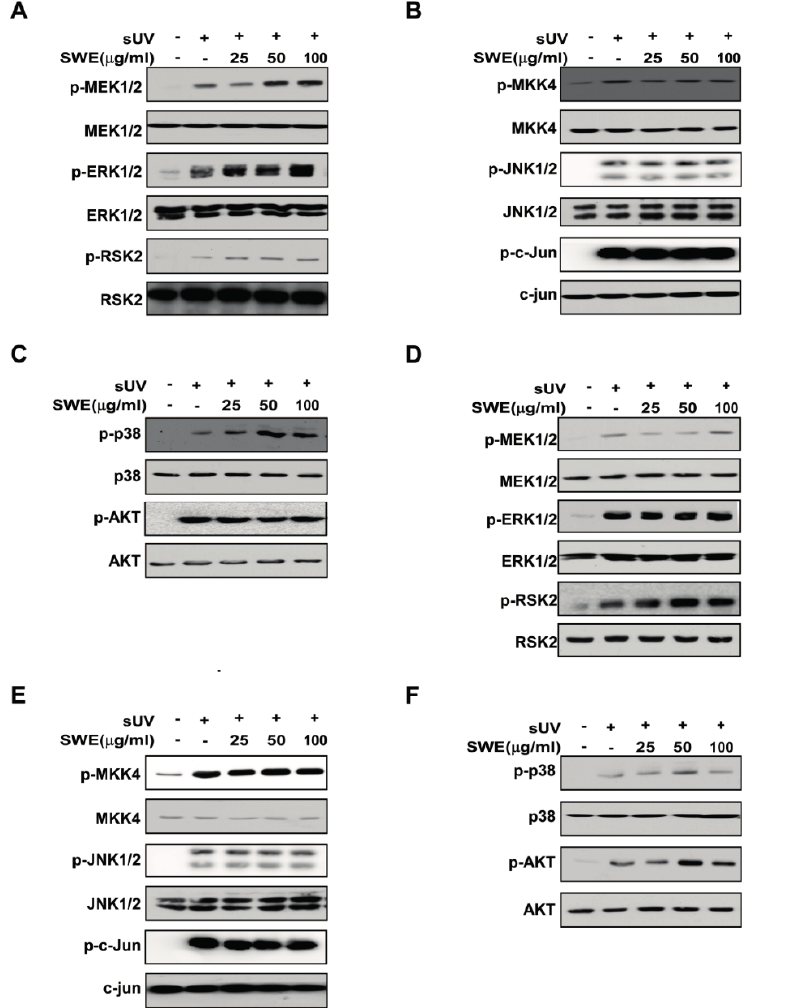
Figure 3. Effects of SWE on sUV-induced signaling in JB6 and HaCaT cells. JB6 ( A – C